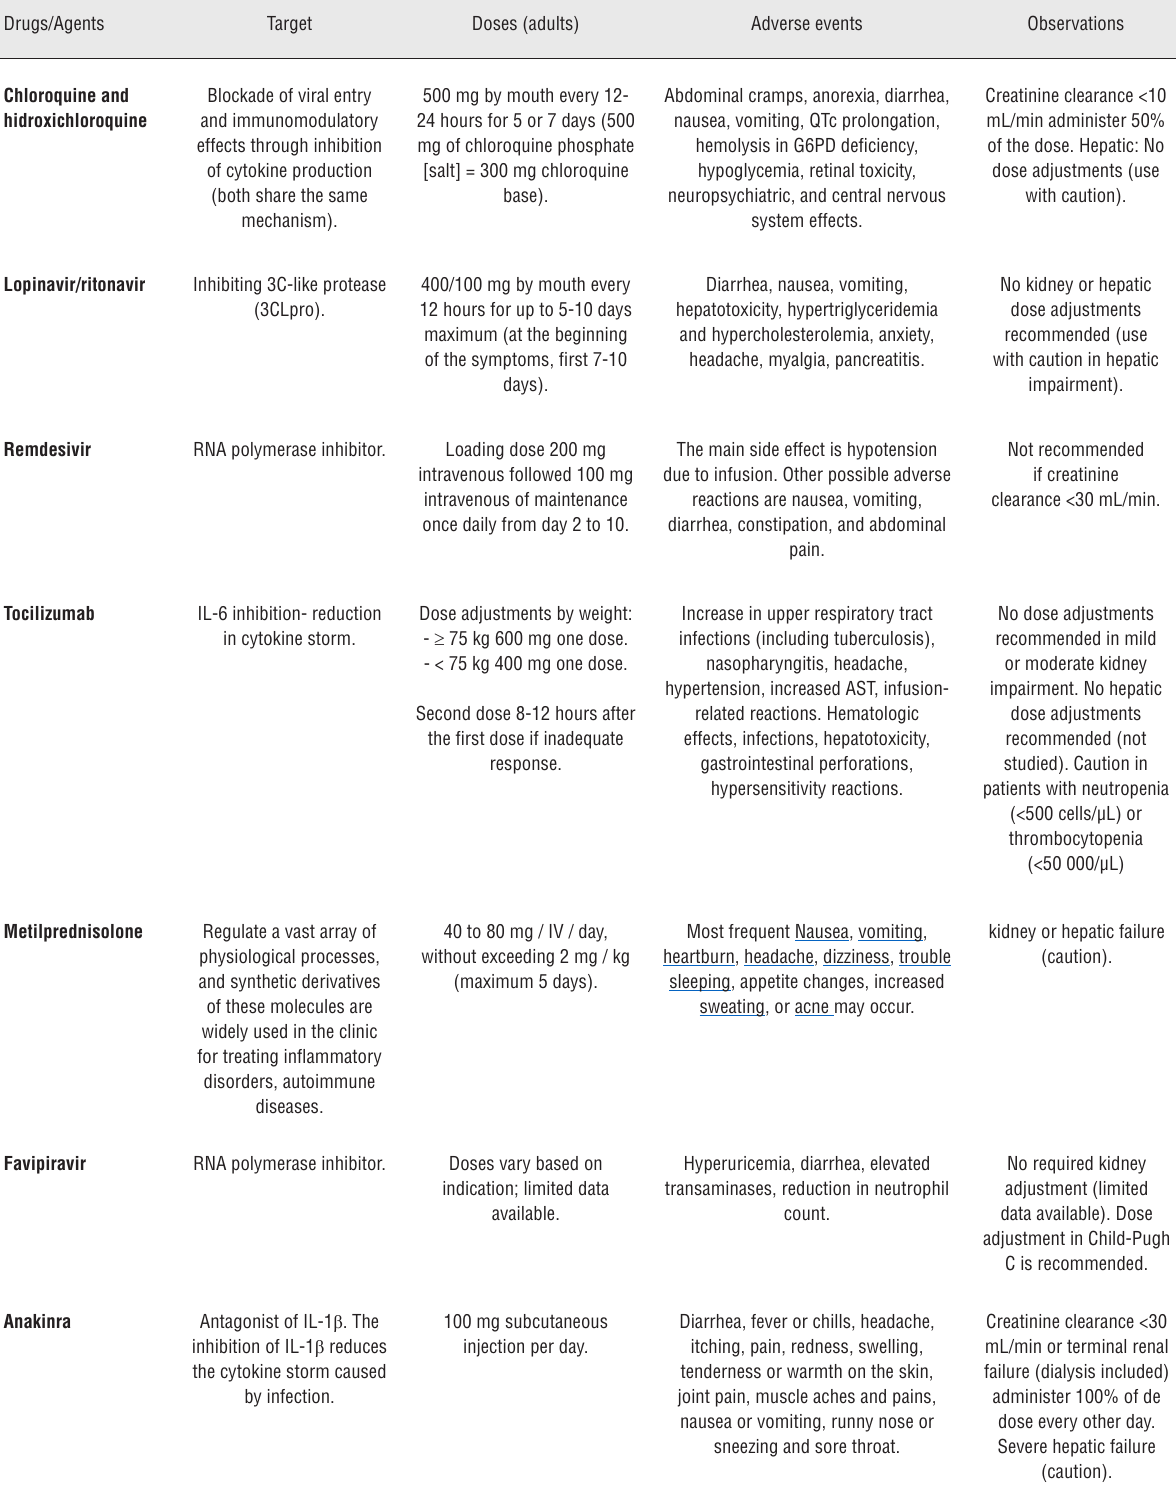
Table 1 - Summarizes the mechanism of action of select treatments or adjunctive therapies for COVID-19.